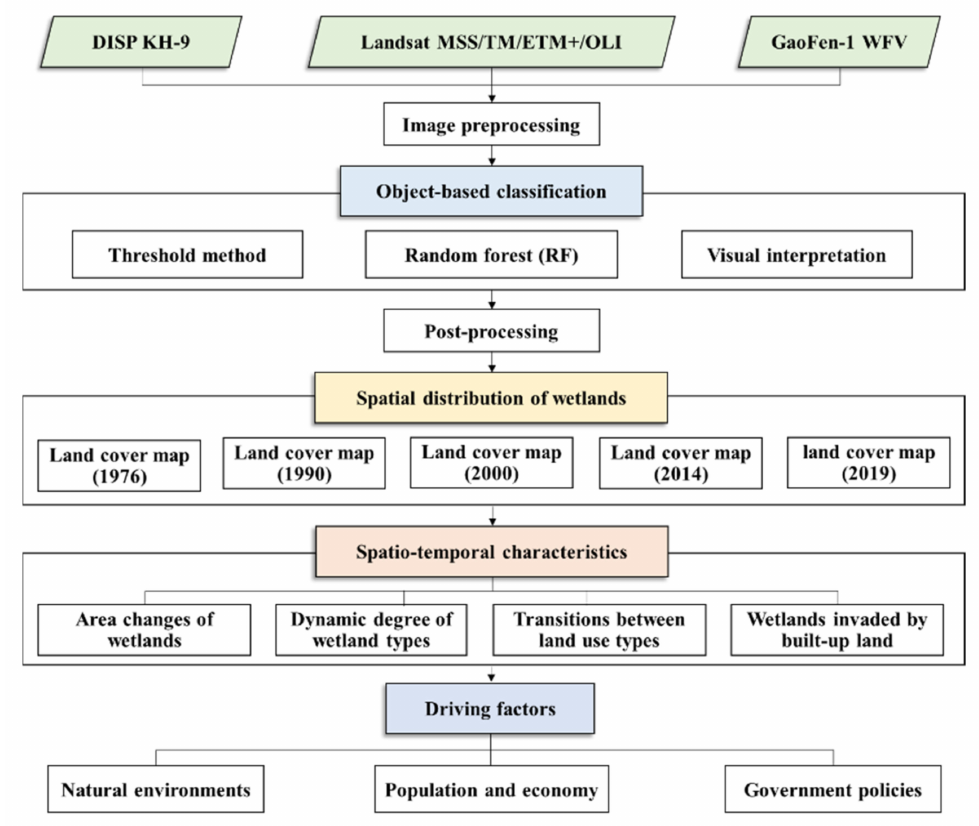
Figure 2. Flowchart of wetland dynamic monitoring in this study.